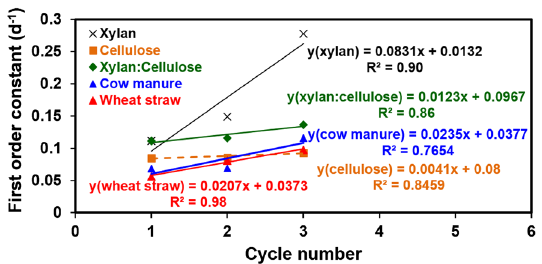
Fig. 2 Variation of the kinetic (reaction rate constant) during the suc- cessive cycles of anaerobic